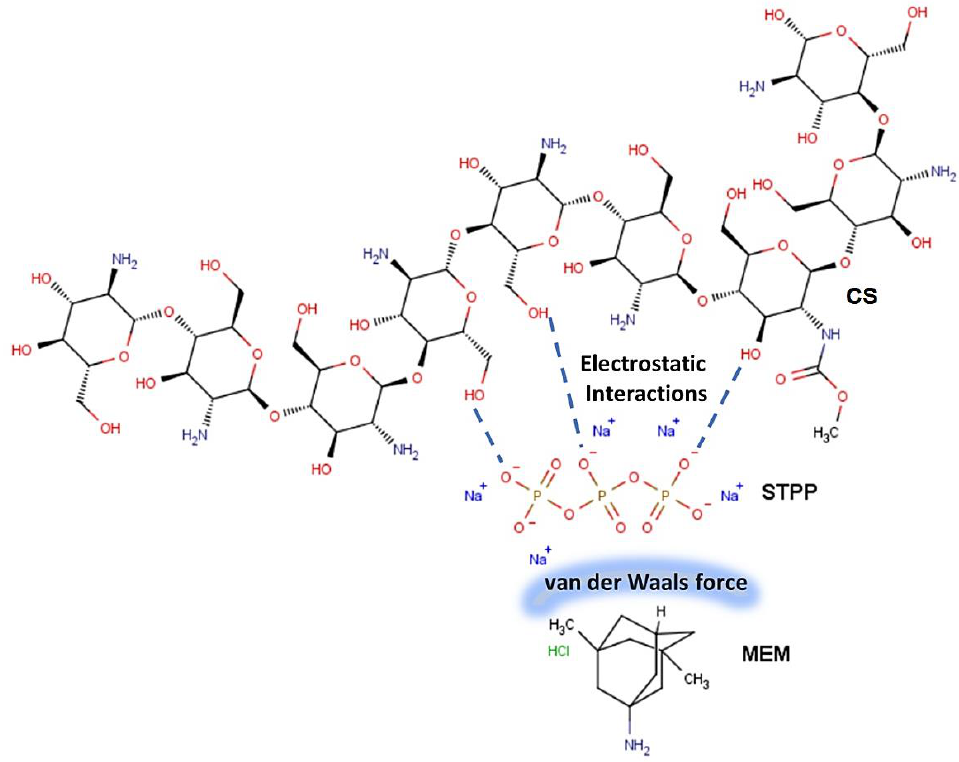
Scheme 1. Schematic diagram of the chemical reactions between MEM, STPP, and CS.